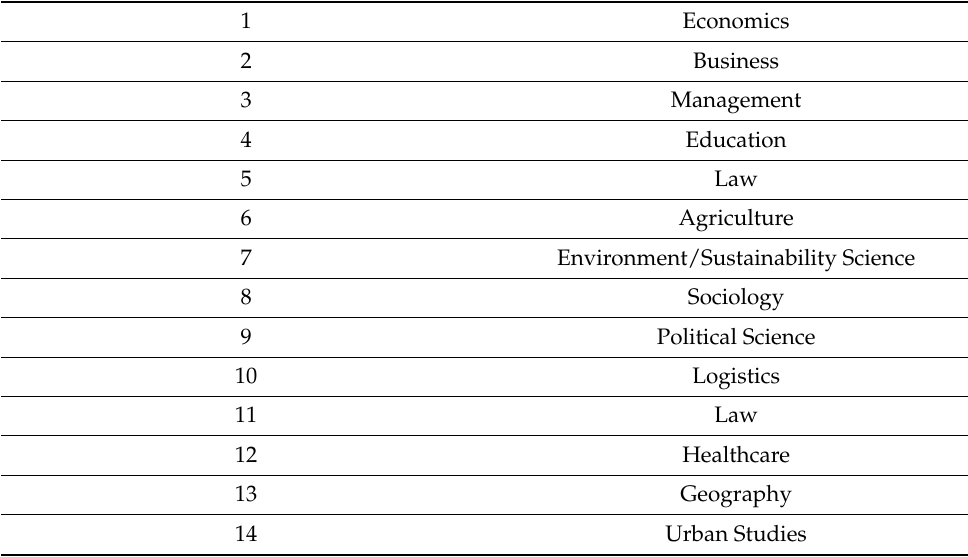
Figure 2. Most popular publishers by journals from the final sample. Table 1. Addressed fields by publications in the final sample.